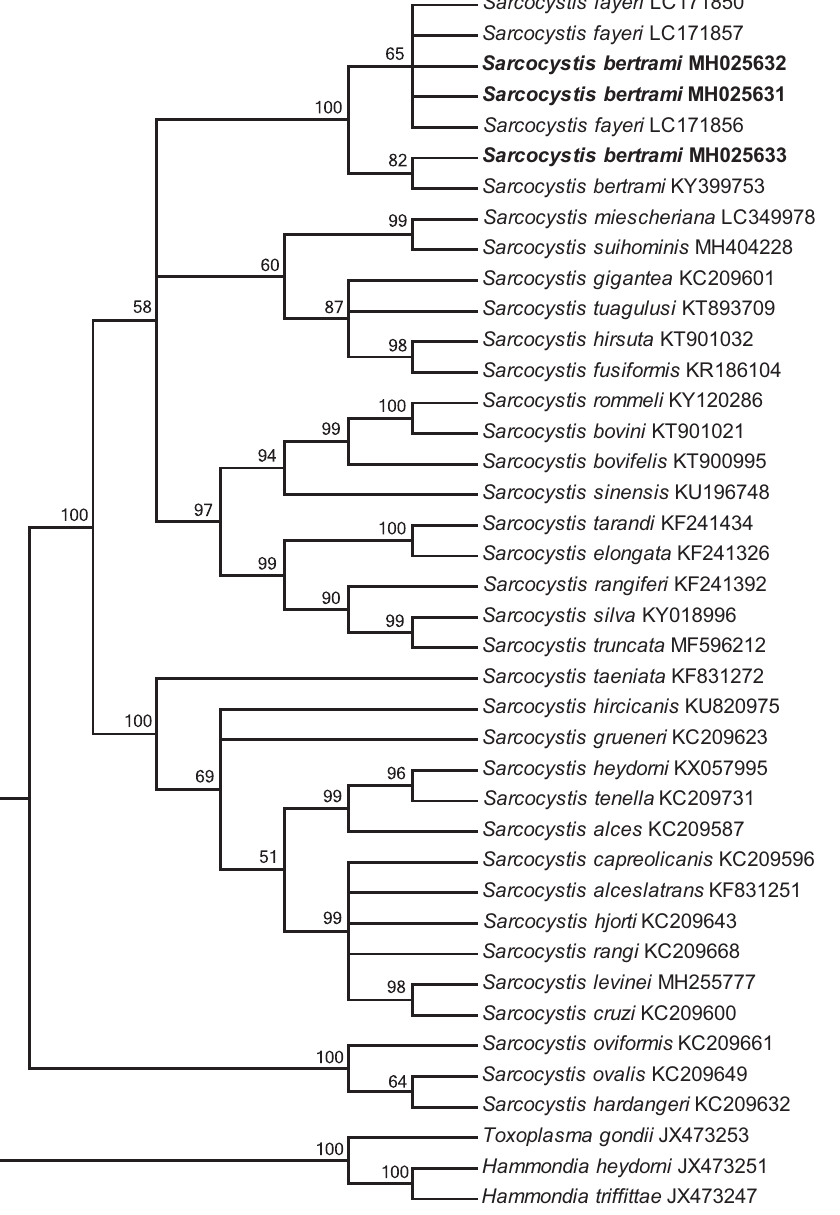
Figure 4. Phylogenetic tree based on mitochondrial cox1 sequences. The tree was built using the maximum parsimony method with the Tree- Bisection-Regrafting algorithm. The analysis involved 40 nucleotide sequences (GenBank accession numbers behind the taxon names) and a total of 936 positions in the fi nal dataset. The values between the branches represent the bootstrap values per 1000 replicates, and values below 50% are not shown. The three new sequences of Sarcocystis bertrami (MH025631 – MH025633 shown in boldface) formed a clade with S . bertrami and S . fayeri from horses within a group comprising Sarcocysti s spp. from pigs and